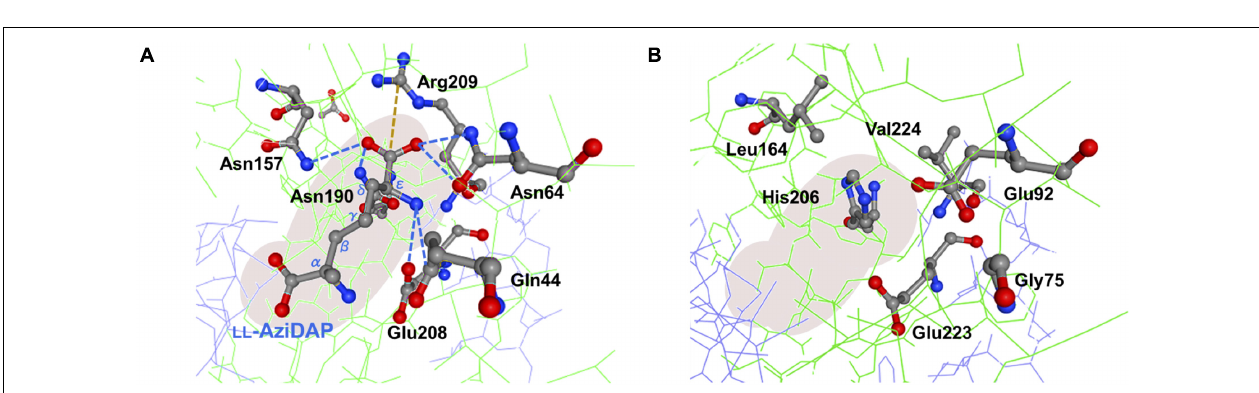
FIGURE 7 | Predictive active site model for PddB. (A) Schematic representation of interactions between the non-reacting stereocenter of LL -AziDap and the six amino acid residues within the active-site cavity of Hi-DapF (PDB ID: 2GKE). Hydrogen bonds and a salt bridge are shown in blue dotted lines and brown dotted line, respectively. (B) Active site model for PddB generated in the SWISS-MODEL server using the structure of Hi-DapF as a template. Configuration of amino acid residues corresponding to the six active site residues in Hi-DapF are schematically shown.